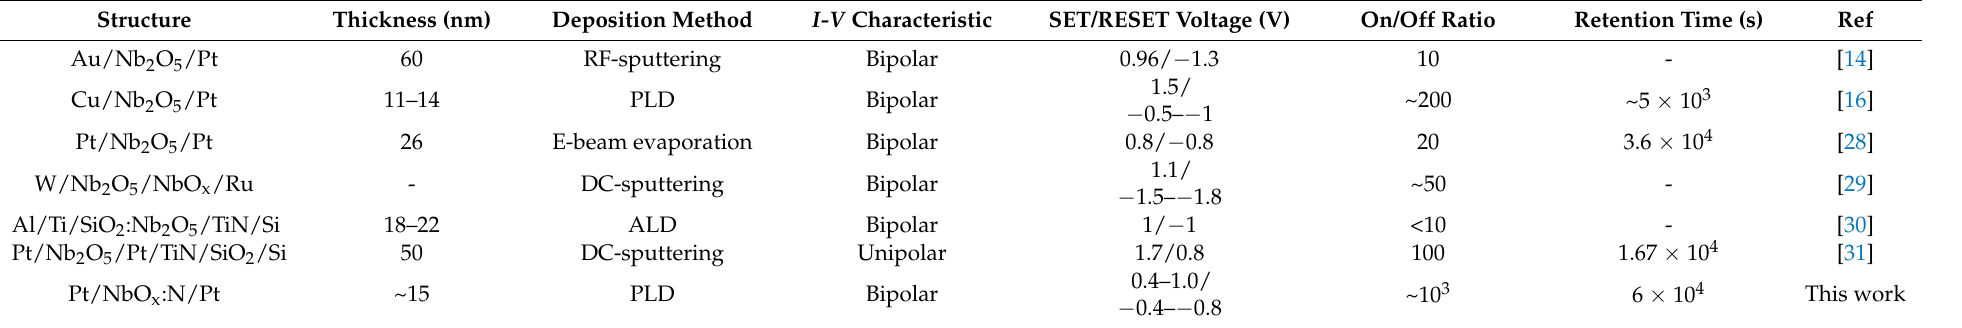
Table 1. Performance of NbO x -based memory RS devices, prepared in this paper and compared with previous